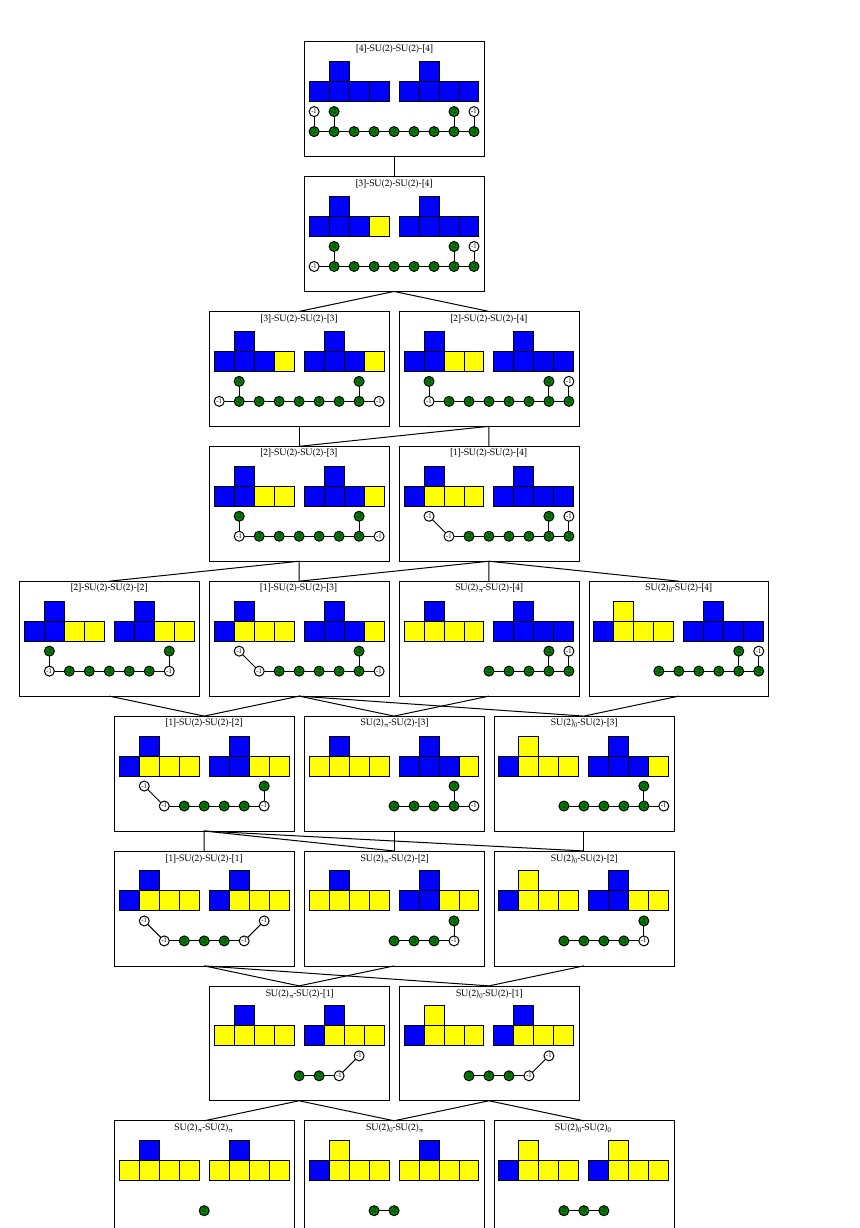
Figure 35. ( D 5 ; D 5 ) Conformal Matter: the marginal theory in the description as the quiver 4 F (cid:0) SU(2) (cid:0) SU(2) (cid:0) 4 F . All of the descendant 5d theories of such a 5d marginal theory are given in the tree above, as determined through the (cid:13)avor-equivalence classes of box graphs. The codimension two (cid:12)ber, which is a splitting of a(cid:14)ne SO(20), can be reconstructed in each case, and we draw the curves inside the (cid:12)ber that are also contained inside of the compact surfaces in the lower half of each box. The reduced CFDs are shown from, which we determine the superconformal (cid:13)avor symmetry.